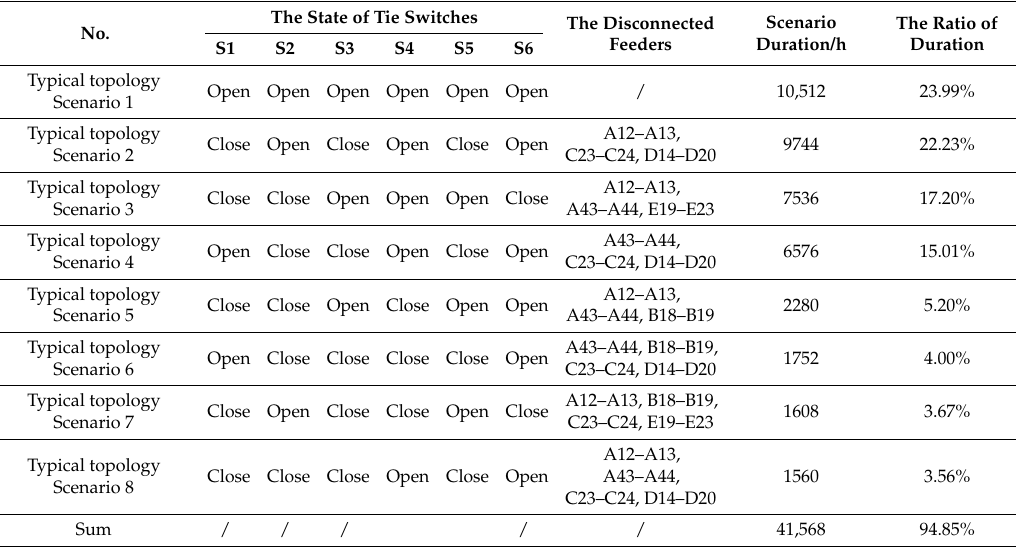
Table 2. The typical topology scenarios information of the 173 nodes